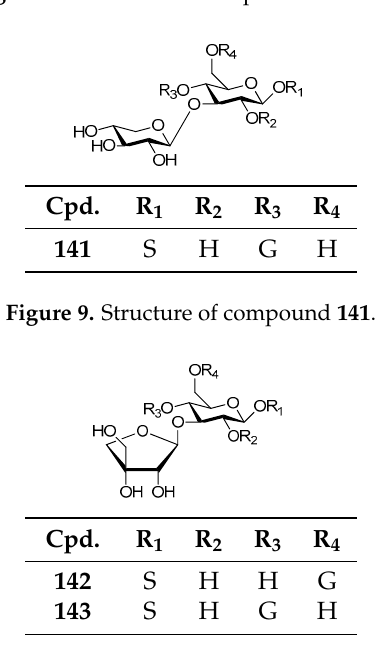
Figure 8. Structures of compounds 122 – 140 .